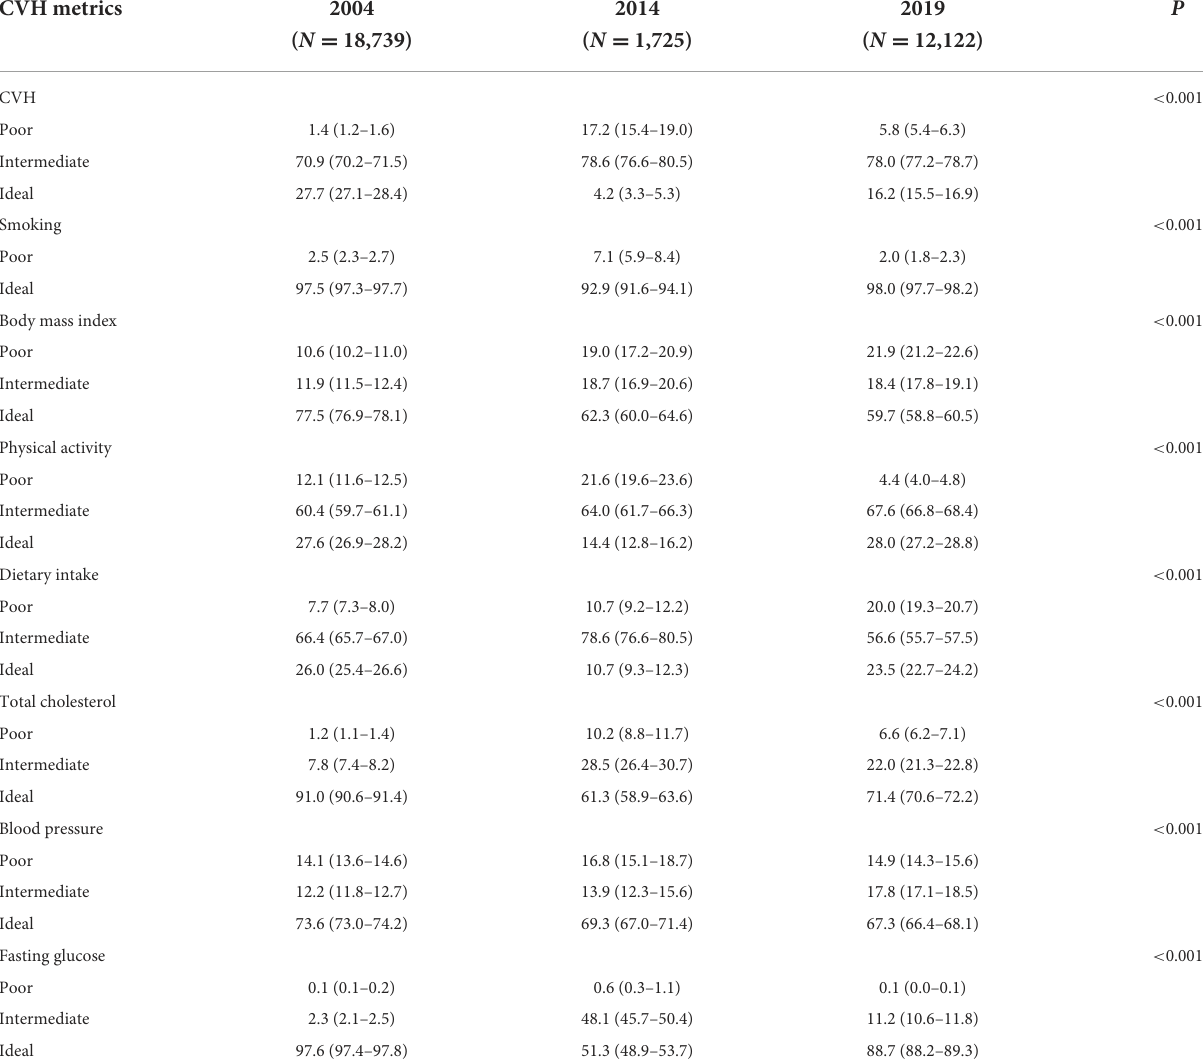
TABLE 4 Proportions (95% CI ) of poor, intermediate, and ideal cardiovascular metrics in total population: